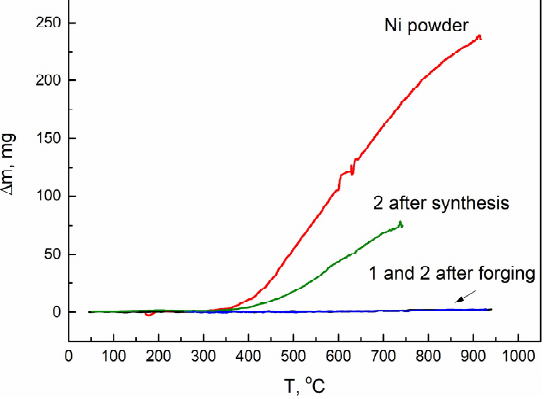
Fig.2. TG curves obtained for specimens 1 and 2 before after forging and pure nickel powder.